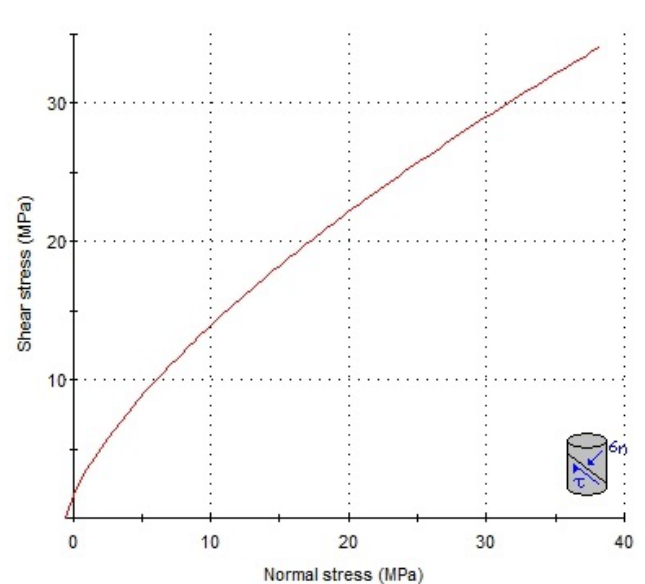
Table 4. Results of the geomechanical properties of limestone.